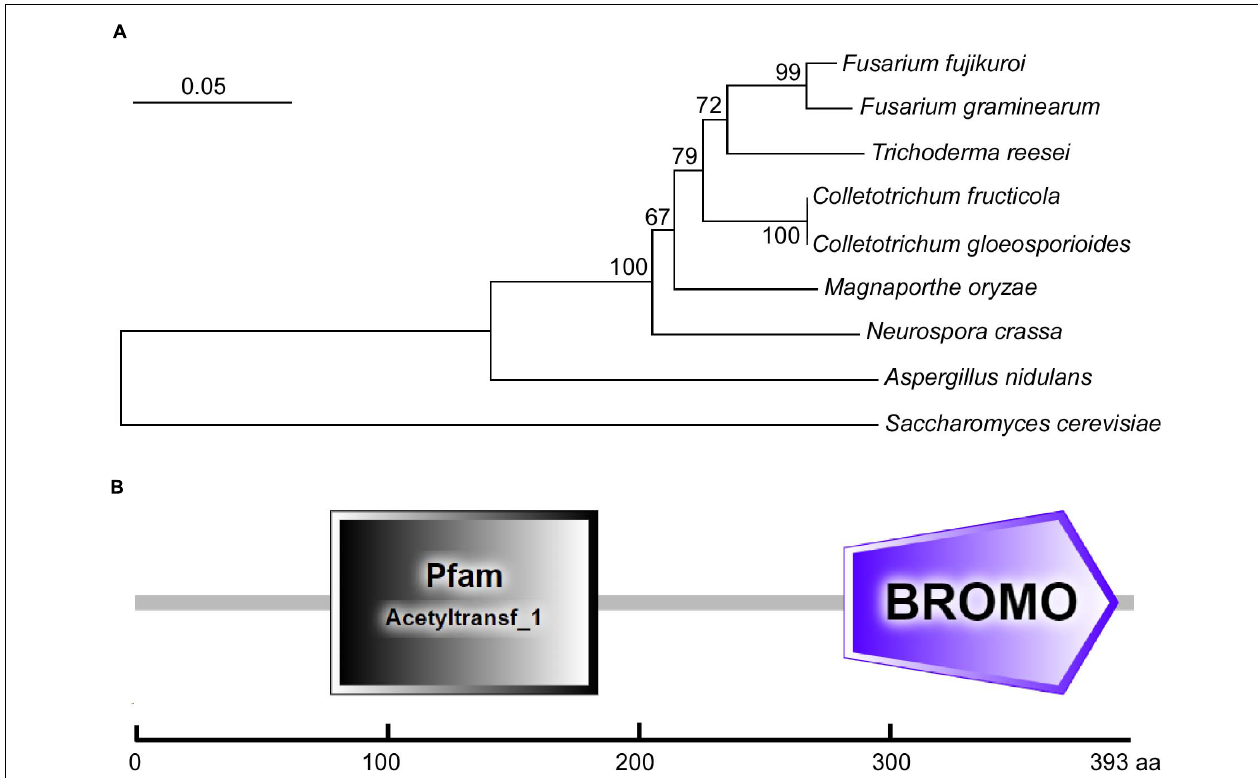
FIGURE 1 | Phylogenetic analysis and domain prediction of CfGcn5. (A) The Gcn5 proteins from diverse fungi were aligned using CLUSTAL_W, and the phylogenetic tree was constructed using MEGA 7.0 and the neighbor-joining method with 1000 bootstrap replicates. The sequences were collected from the NCBI database and the GenBank accession numbers are shown as follows: F. fujikuroi (XP_023425542.1), F. graminearum (XP_011324943.1), T. reesei (XP_006966860.1), C. fructicola (MW701426), C. gloeosporioides (EQB51886.1), M. oryzae (XP_003716207.1), N. crassa (XP_001728480.2), A.